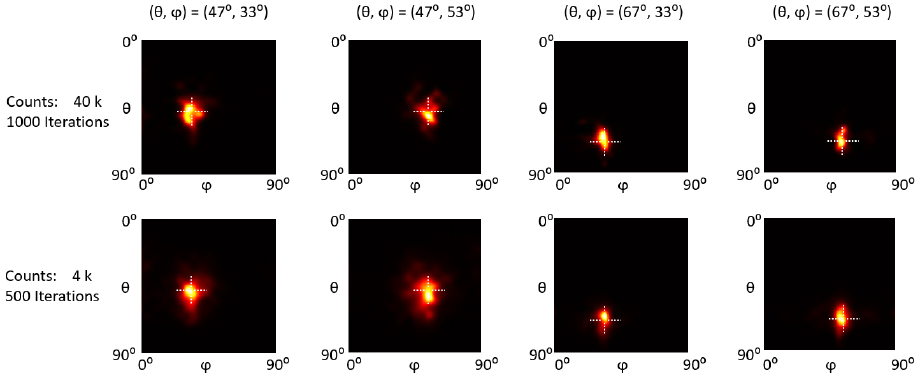
Figure 10. Reconstruction images of a 137 Cs point sources at different positions with different count levels. The intersections of the dotted lines indicate the actual positions.